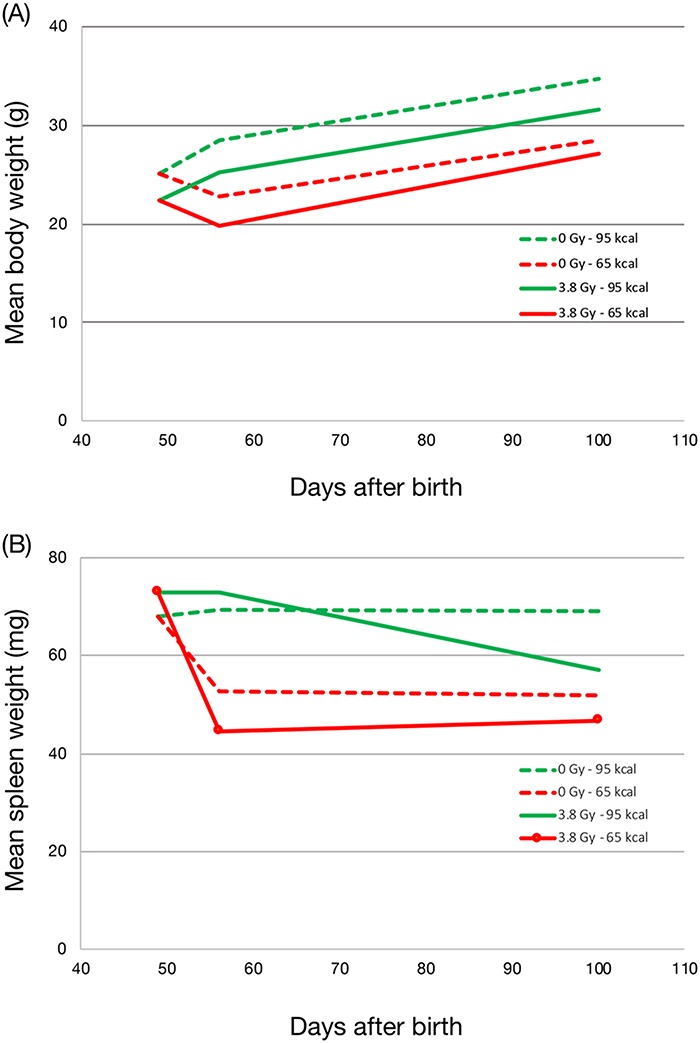
Effect of calorie restriction on body weight (A) and spleen weight (B). Mice were fed on either 95 kcal/week (green lines) or 65 kcal/week (red lines) diets from the age of 7-weeks and sacrificed at the ages of 7-weeks-old, 8-weeks-old and 100-days-old. Body weights and spleen weights were monitored at the time of sacrifice. Solid line: mice irradiated with 3.8 Gy X-rays; dotted line: unirradiated mice.